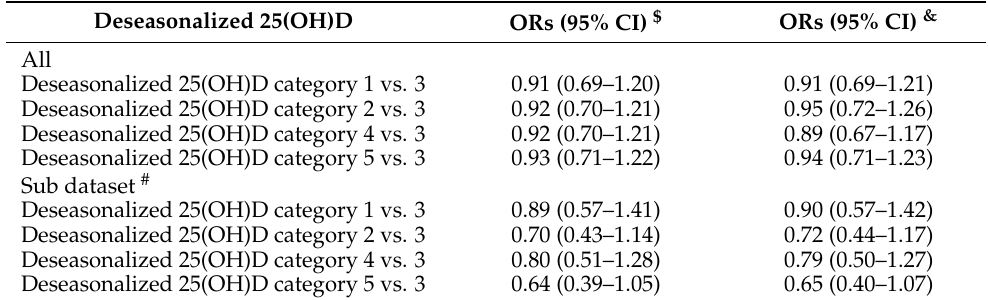
Table 2. Odds ratios from the logistic regression model for deseasonalized vitamin D levels.